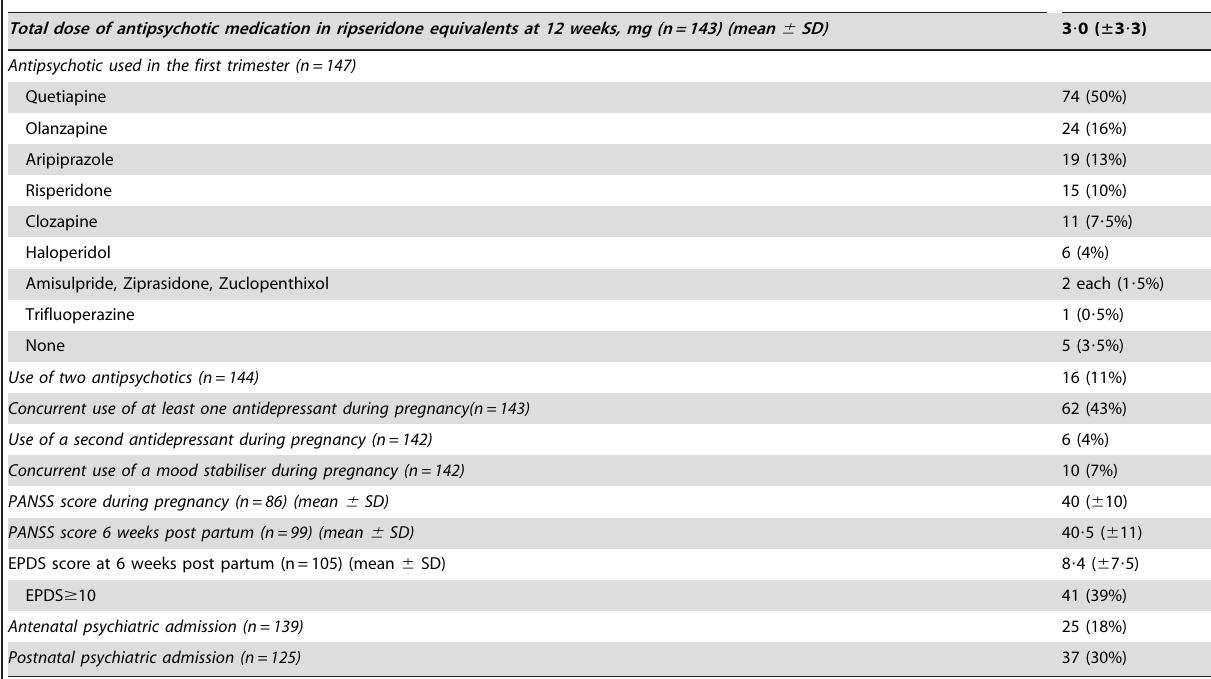
Totaldoseofantipsychoticmedicationinrisperidoneequivalentspriortopregnancy,mg(n=142)(mean 6 SD) Totaldoseofantipsychoticmedicationinripseridoneequivalentsat12weeks,mg(n=143)(mean 6 SD)